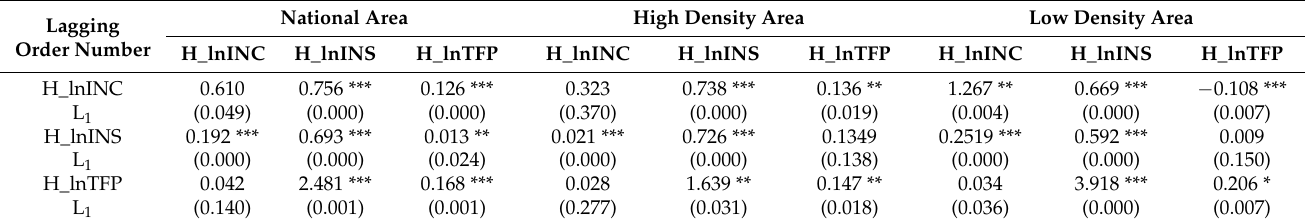
Table 4. GMM estimation results of PVAR